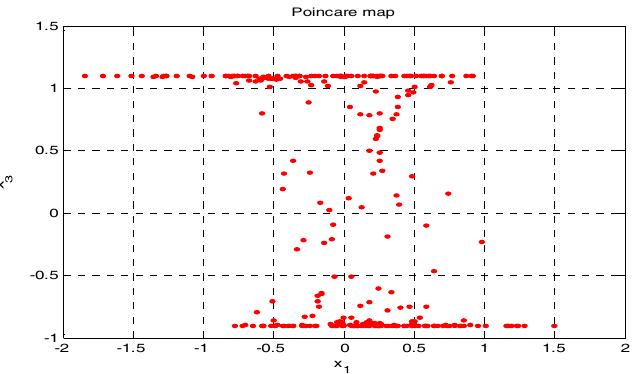
Figure 4. Poincaré mapping of the double ‐ scroll attractor ( s 11 = s 12 = s 13 = a 32 = 1; s 21 = − 1; s 22 = 1.2; n = 10, i 3 Figure 4. Poincar é mapping of the double-scroll attractor ( s 11 = s 12 = s 13 = a 32 = 1; s 21 = − 1; s 22 = 1.2; = 0.1). n = 10, i 3 =